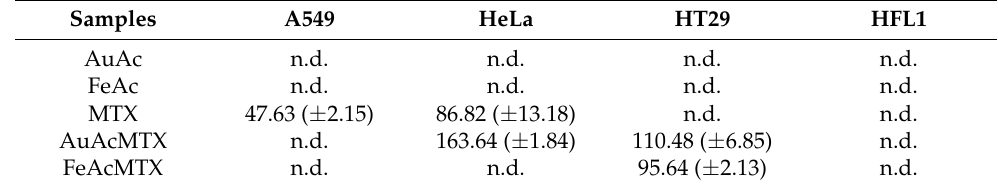
Table 2. IC 50 values ( µ g/mL) determined by MTT assays following 72 h treatment with test-compounds.